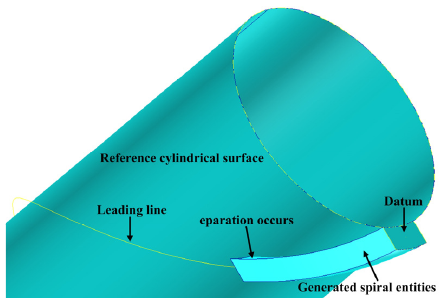
Figure 2. Generated spiral entities.